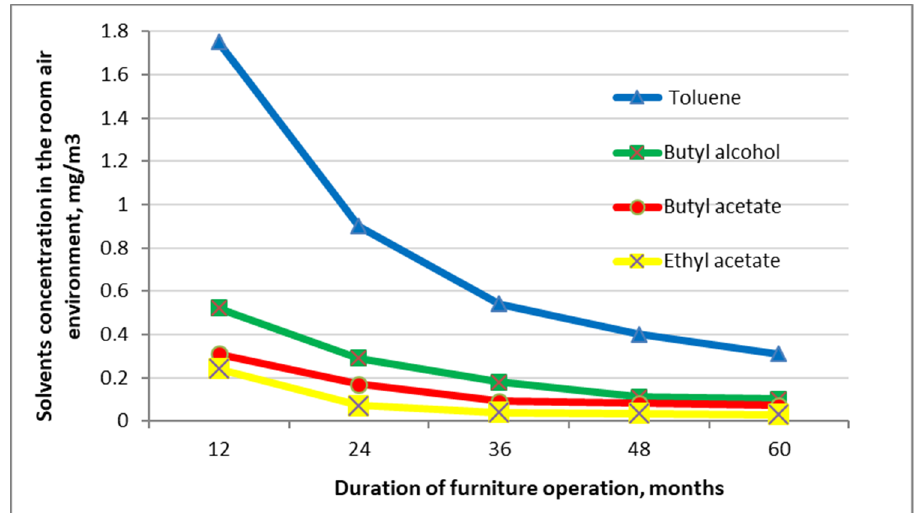
Figure 2. Kinetics of solvent concentration in the air environment of a room when operating furniture.